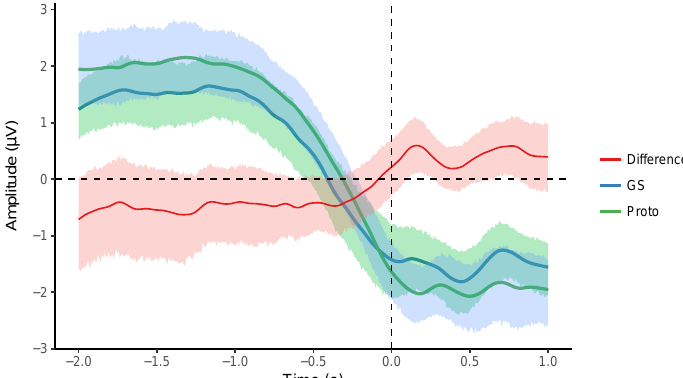
Figure 6. Grand averages and difference (GS-Proto) along with 95% confidence intervals for the averaged MRCPs ( n = 22). Time at 0 s corresponds to the movement onset.